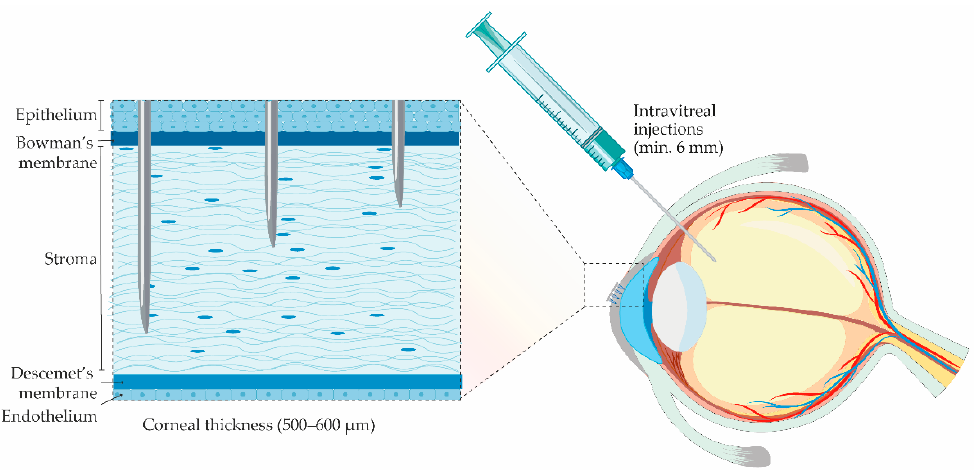
Figure 4. Comparison of ocular administration of intravitreal injection and microneedles (MNs). Due to the MN length and curvature of the corneal, all tissue structures can be reached. In com- parison, during intravitreal injection, it is necessary to insert the needle into the vitreous to a depth exceeding 6 mm [276].